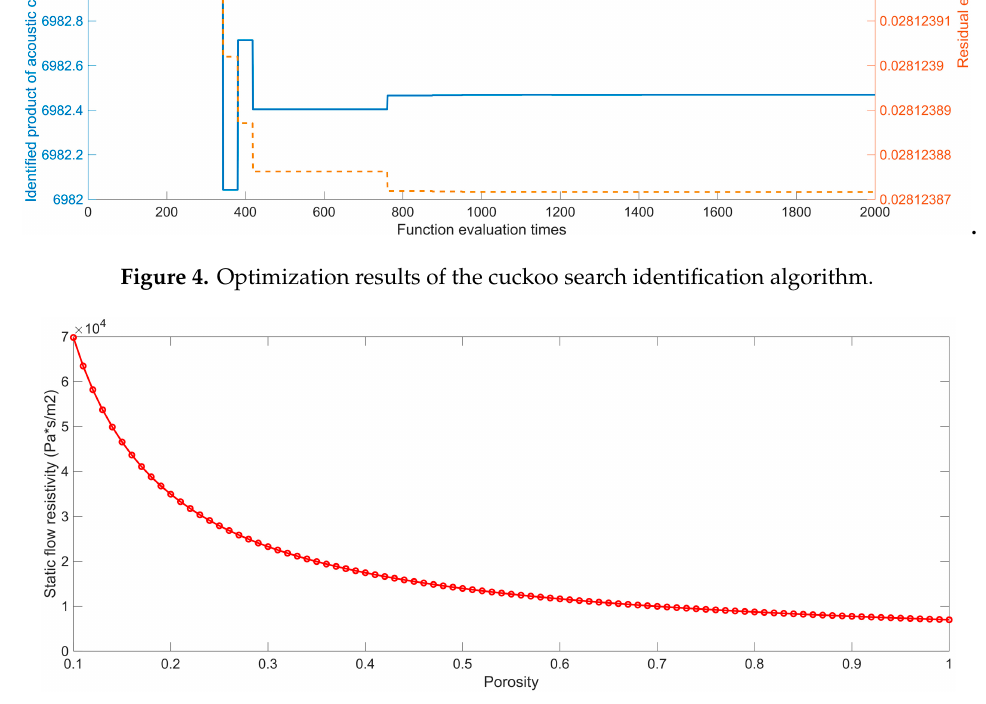
Figure 5. Distribution of the optional acoustic characteristic parameters of static flow resistivity and porosity.